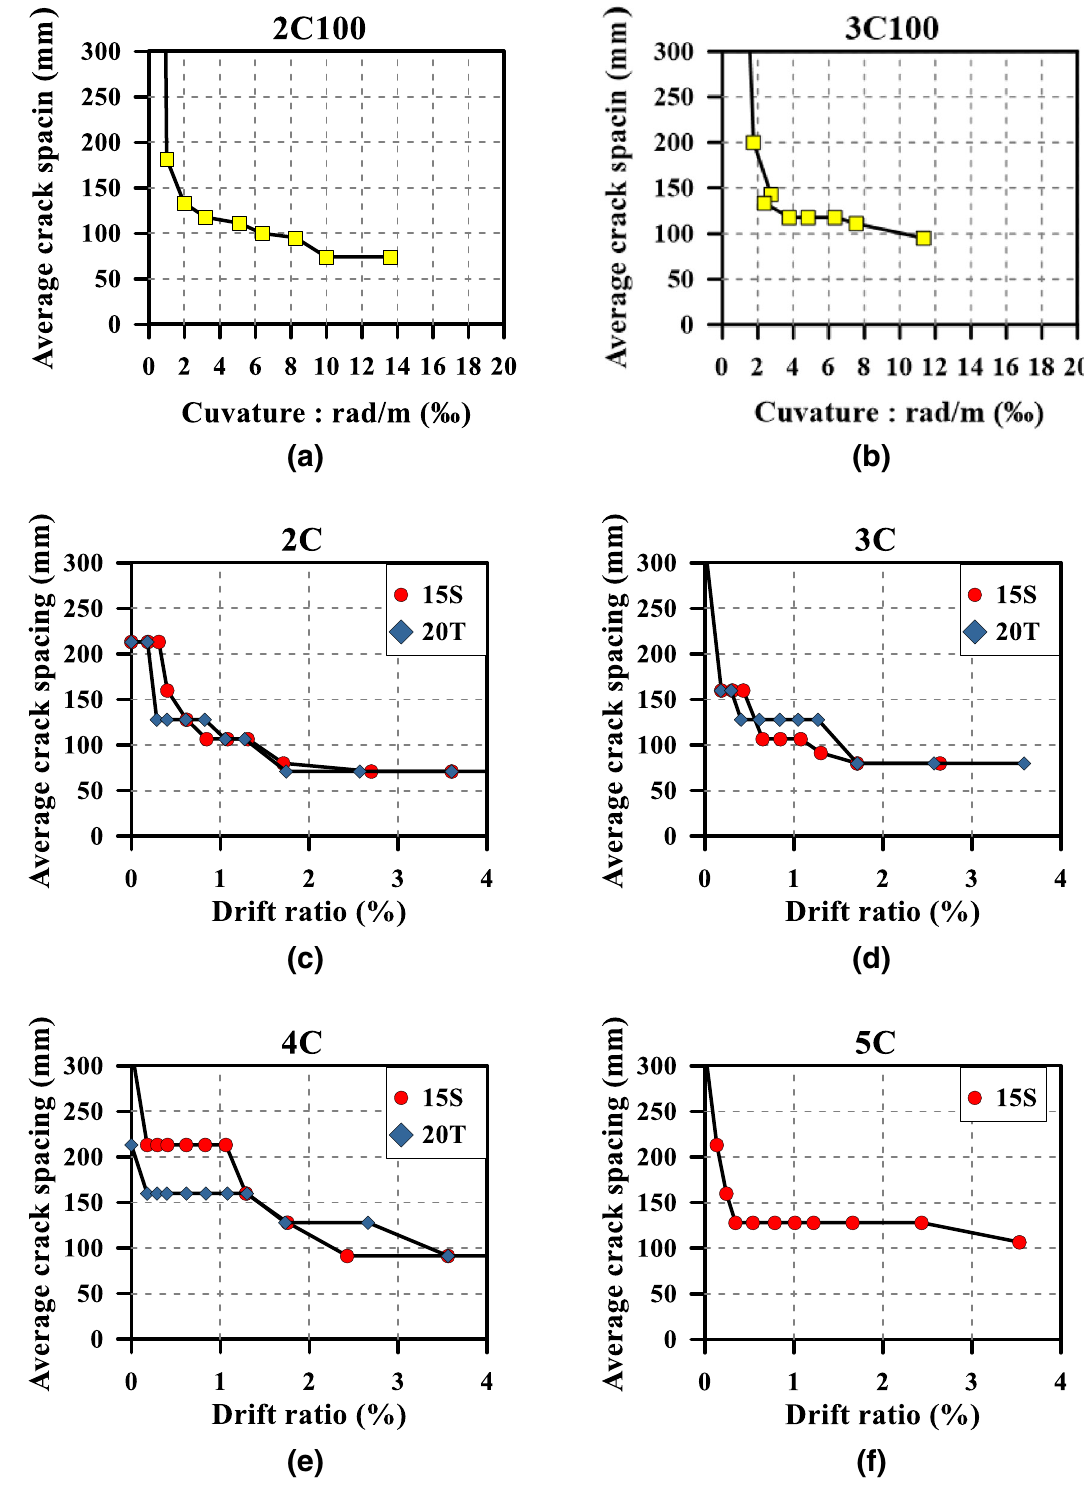
Fig. 14 Relationship between the average flexural crack spacing and curvature or drift ratio of member. a 2C100, b 3C100, c 2C15S and 2C20T, d 3C15S and 3C20T, e 4C15S and 4C20T, and f